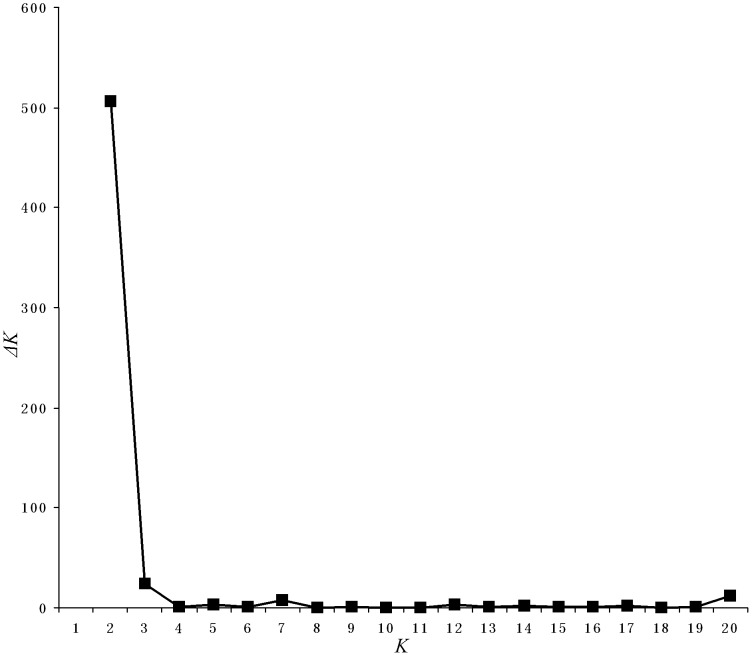
Results of the Bayesian assignment analysis using the program STRUCTURE.The ΔK (Evanno et al. 2005) was plotted against various values of K, suggesting K = 2 as the most likely number of clusters.